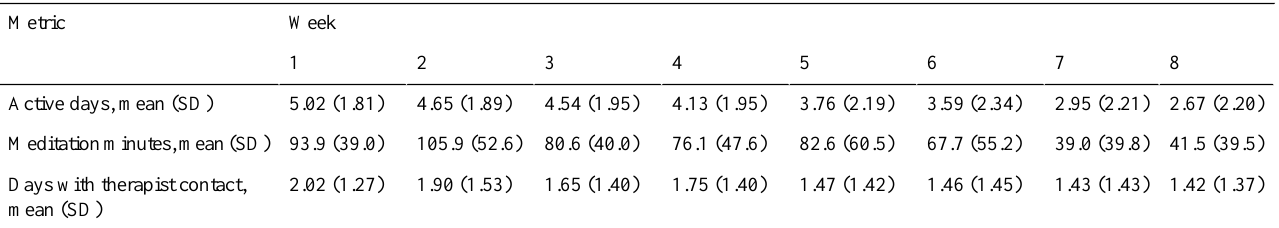
Table 3. Week-by-week intervention engagement across all participants. “Active days” corresponds to >3 minutes of app-based mindfulness practice on a given